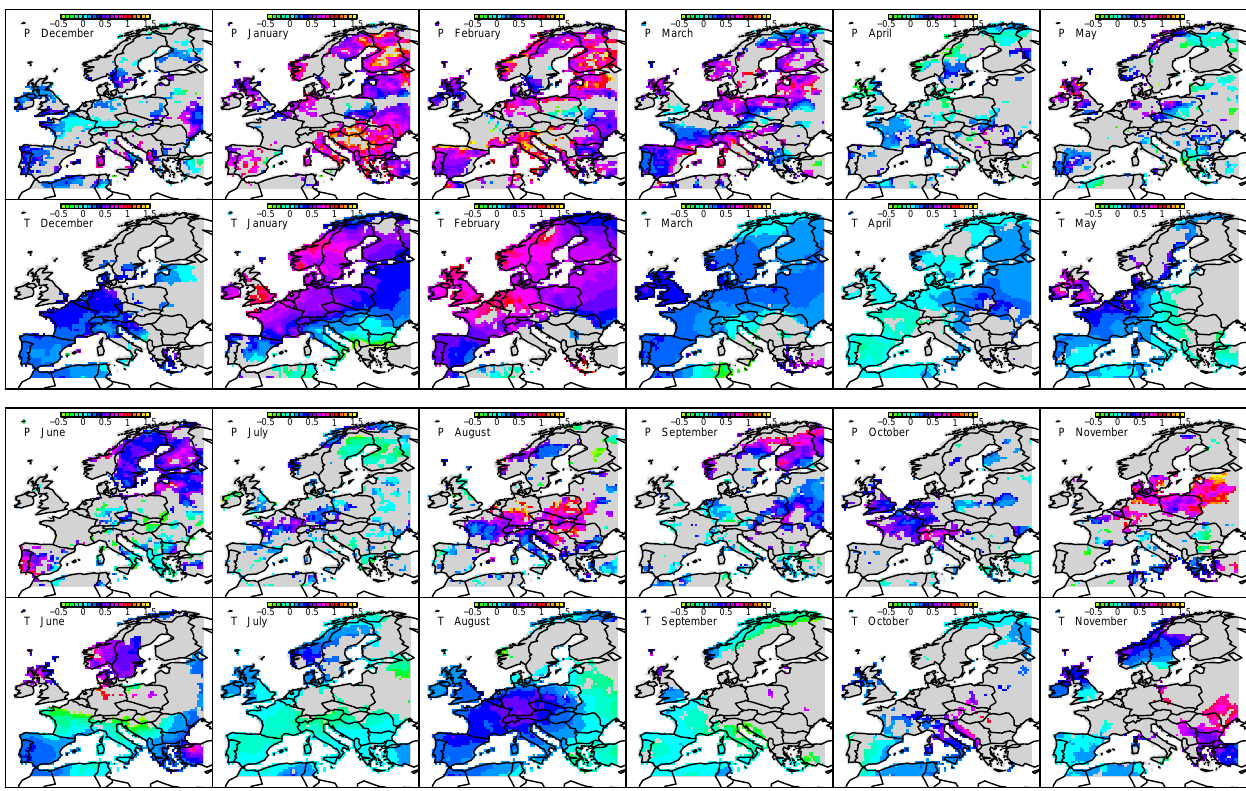
Figure 2. Monthly trend ratios for synoptic-circulation-induced trends in precipitation (rows 1 and 3) and temperature (rows 2 and 4).